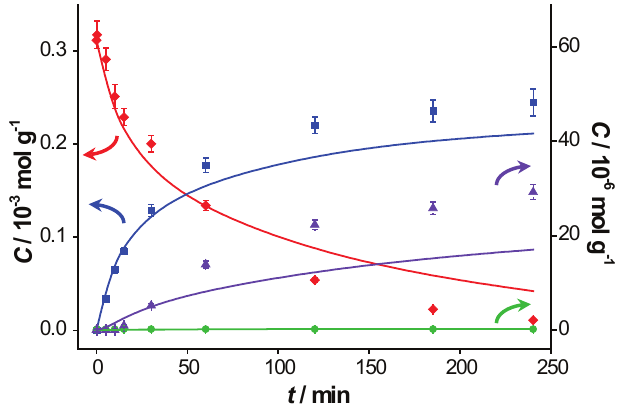
Figure 11. Catalyst performance in the presence of K Concentration profiles of ( ♦ ) benzyl alcohol, ( ■ ) benzaldehyde, ( ● ) benzoic acid and ( ▲ ) benzyl benzoate vs. reaction time for catalytic reaction over fresh AUROlite ™ in the presence of water. Reaction conditions: T = 80 °C, 0.8 g AUROlite ™ , 3.04 g K C = 3.0 × 10 −4 mol·g − 1 , in 80 mL of toluene, 200 mL·min − 1 air flow. Concentrations BnOH, t=0 are expressed in moles per unit mass of liquid in the reactor (mol · g − 1 ). The symbols with error bars are the experimental results and the lines represent the kinetic